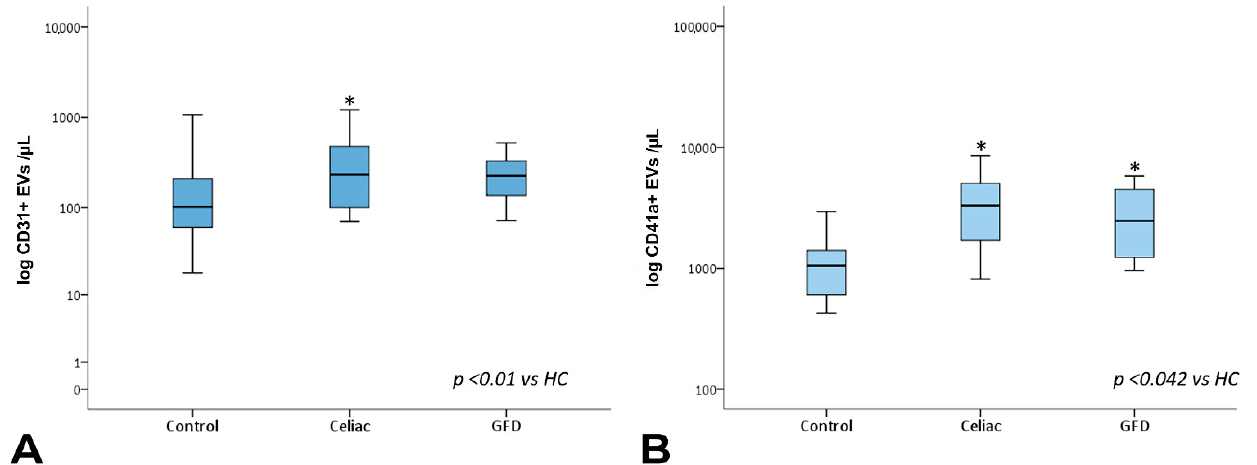
Figure 3. Total CD31+ and CD41a+ EV counts. Box plots represent CD31+ ( A ) and CD41a+ ( B ) EV concentrations (EVs per µ L, log-transformed) in peripheral blood obtained from controls, celiac, and GFD patients. The horizontal line represents the median value. The asterisk (*) identifies statistically significant differences.